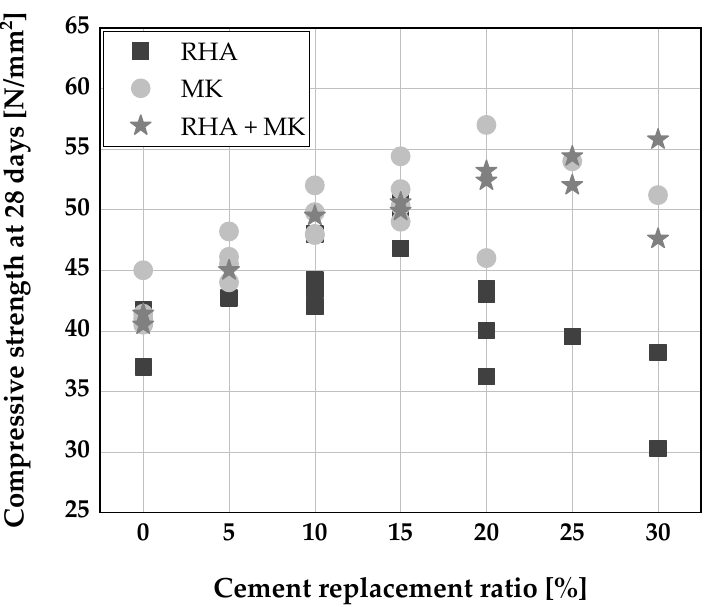
Figure 5. Compressive strength of SCC: Chopra et al. [31], Kannan [30], Kavitha [53], Madandoust [34], Vivek [107], and Gill [61] .